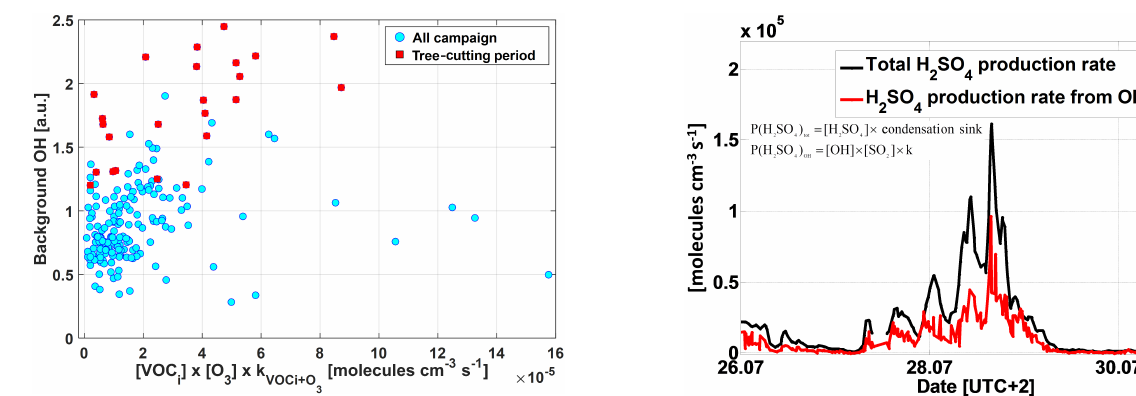
Figure 8. Comparison of the total H 2 SO 4 production rate (black line), calculated from the measured H 2 SO 4 , and the production rate of H 2 SO 4 (red line) involving only the oxidation process of SO 2 by OH for the ground measurements during the HUMPPA- COPEC 2010 campaign.